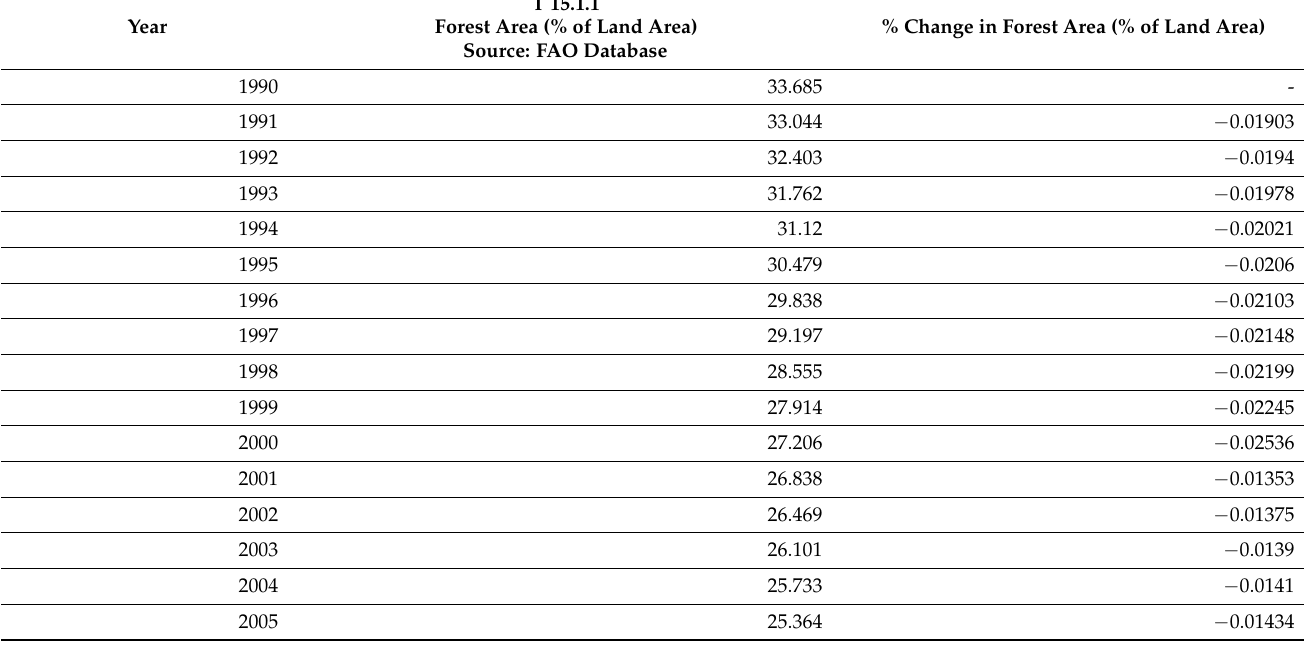
Table A4. Historical dataset for SDG 15 and percent change